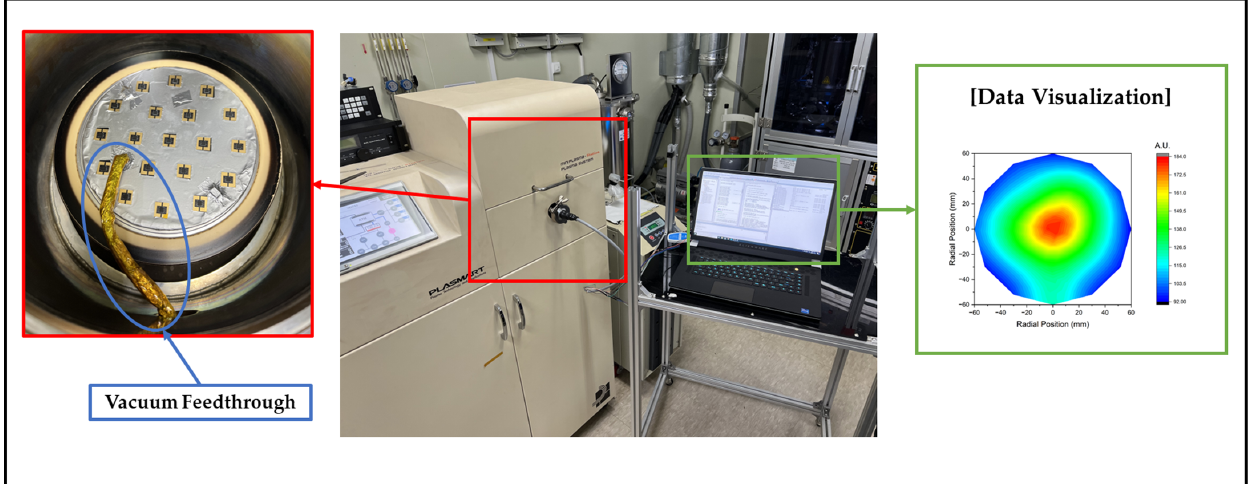
Figure 7. Schematic diagram of the experimental setup.